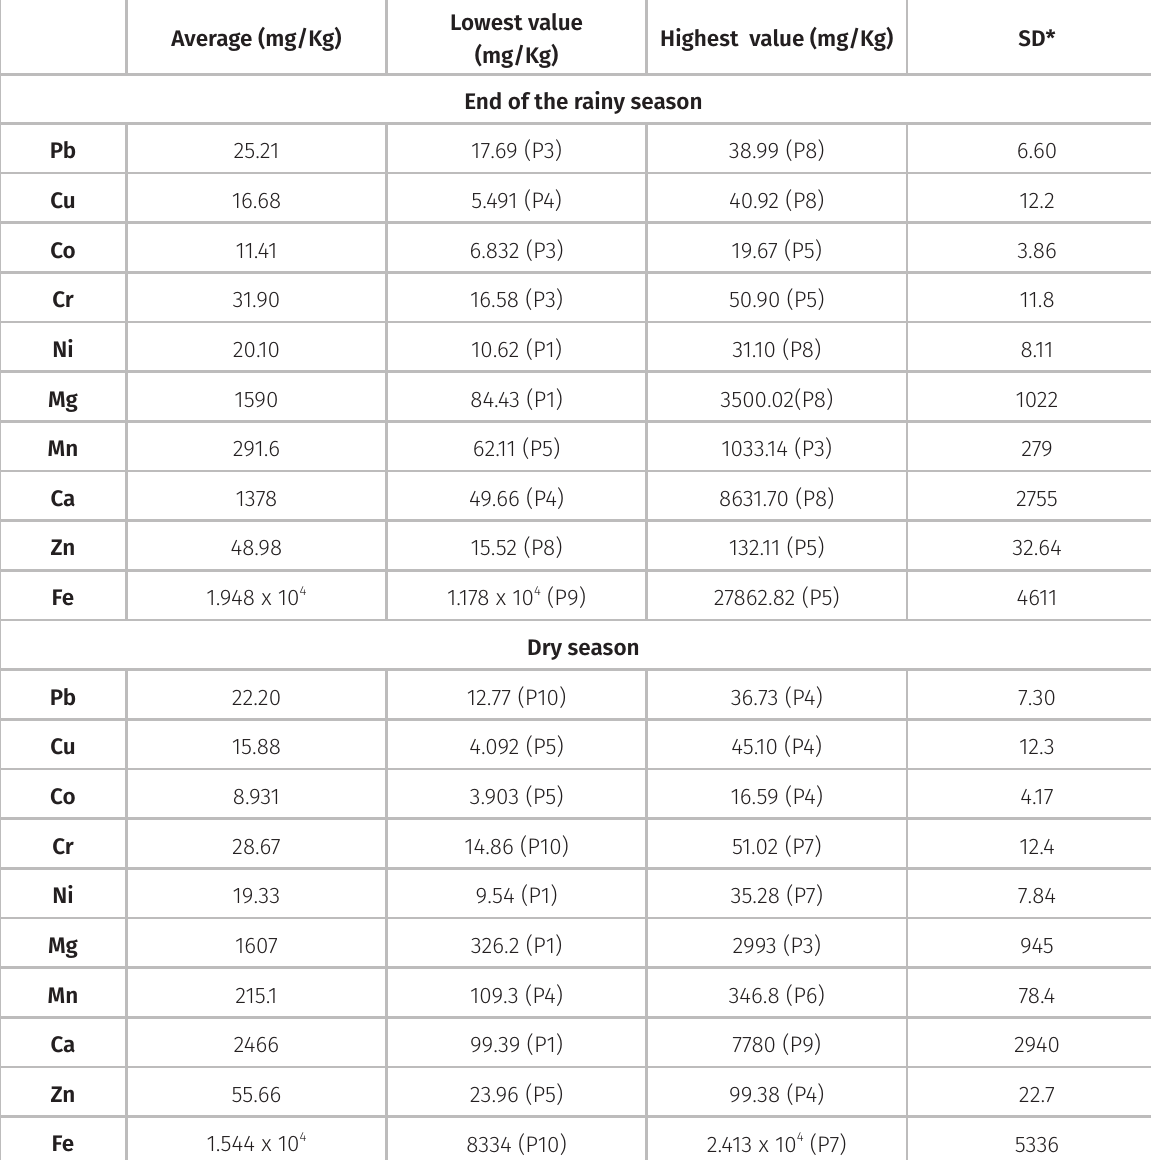
Table III. Descriptive statistics of metal concentrations by pseudo-total digestion in sediment samples from the Jequiezinho